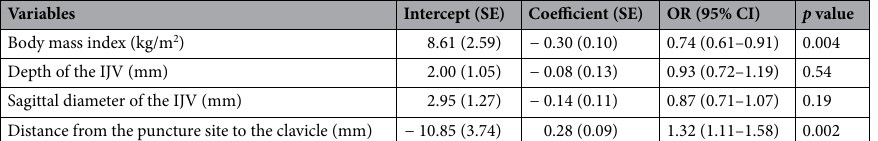
Table 2. Univariate logistic regression for parallel guidewire imaging. CI confidence interval; IJV internal jugular vein; OR odds ratio; SE standard